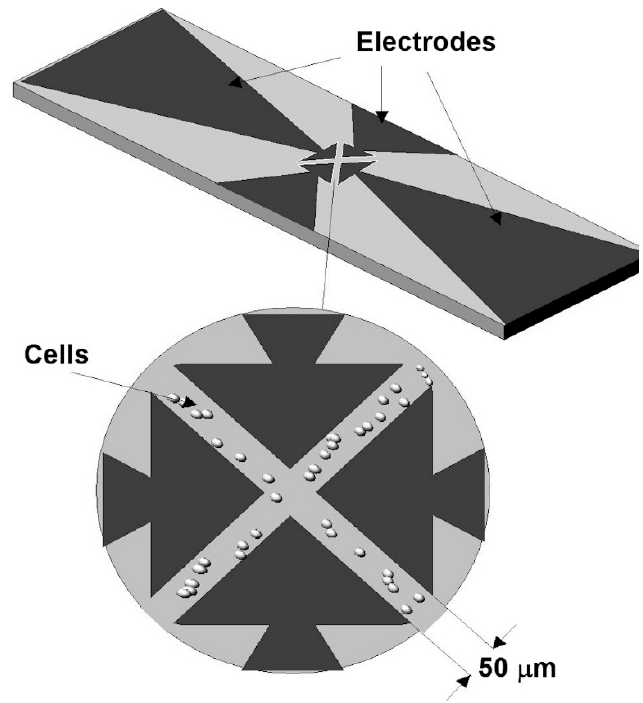
Figure A2. The makeup of the measurement chip containing an electrode quartet.